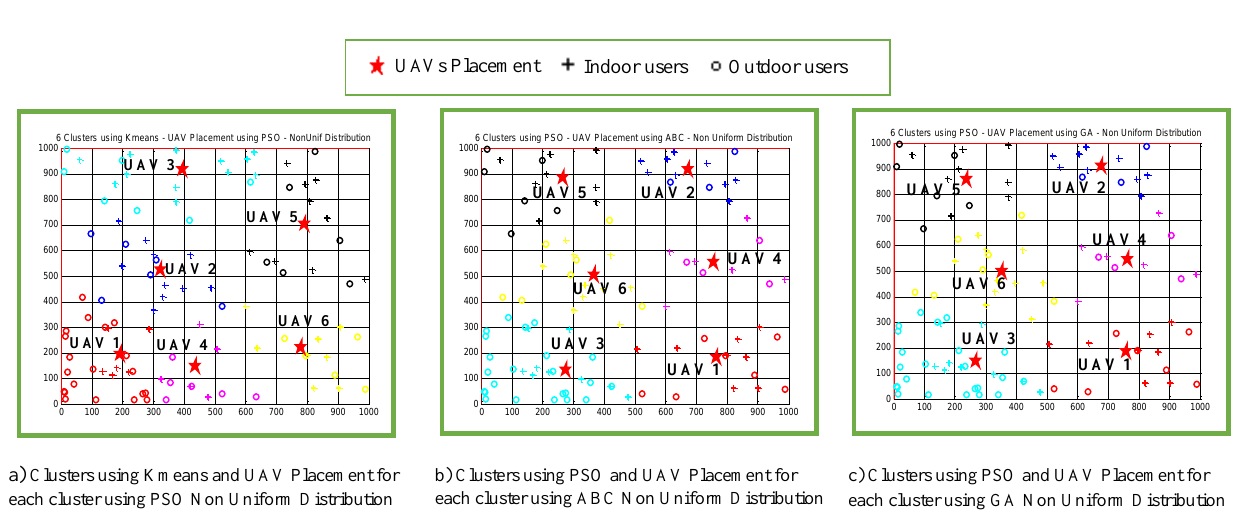
Figure 11. ( a – c ) Placement of UAV1 to UAV6 when users were non-uniformly distributed. Therefore, it was found to be beneficial to employ PSO-based clustering and a PSO- based efficient UAV 3D placement algorithm for the case of users that were distributed uniformly and